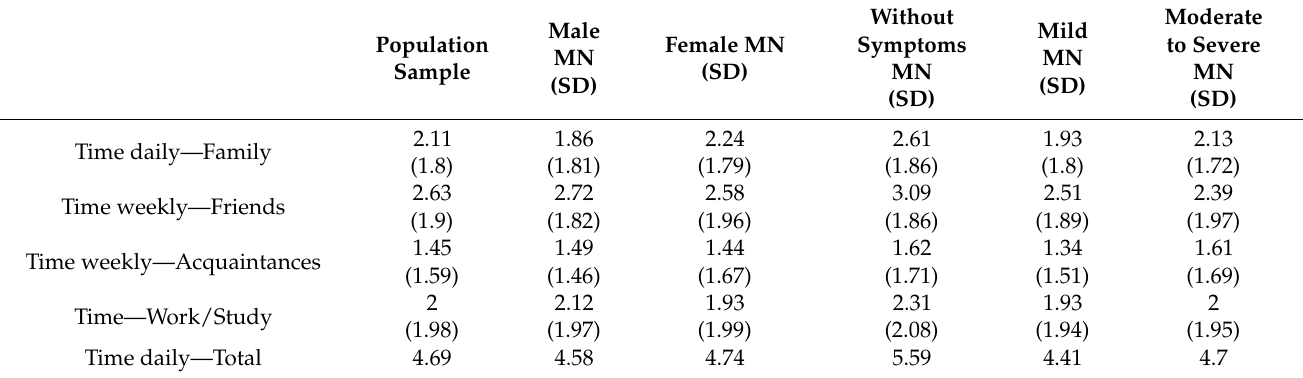
Table 6. Conversation times according to gender and diagnostic